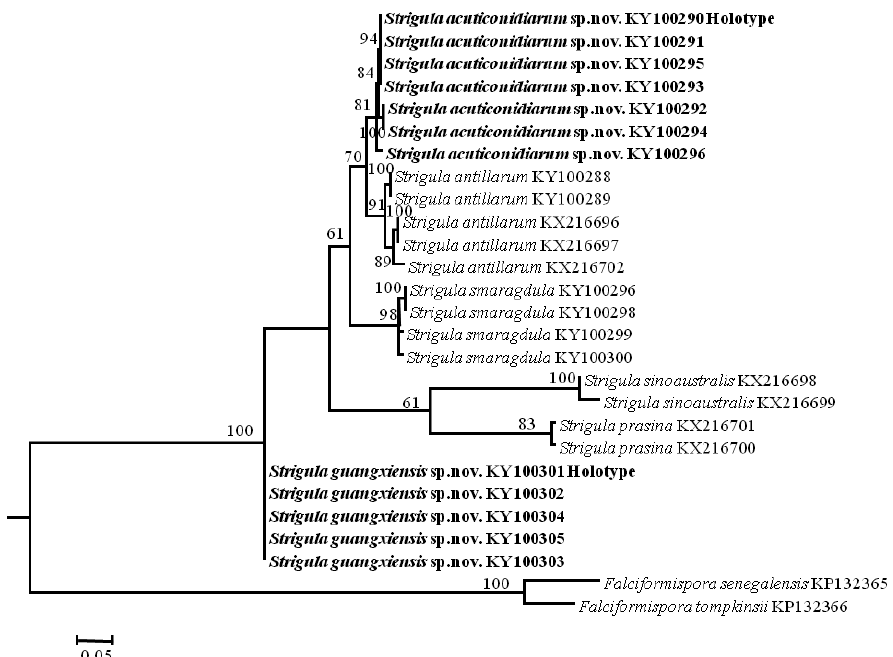
Figure 1. The Maximum Likelihood tree based on nrDNA ITS sequences with 472 bp. Genetic distance scale = 0.05 changes per site. Numbers above each node represents bootstrap support values (value lower than 50 not shown). New species proposed are in boldface.